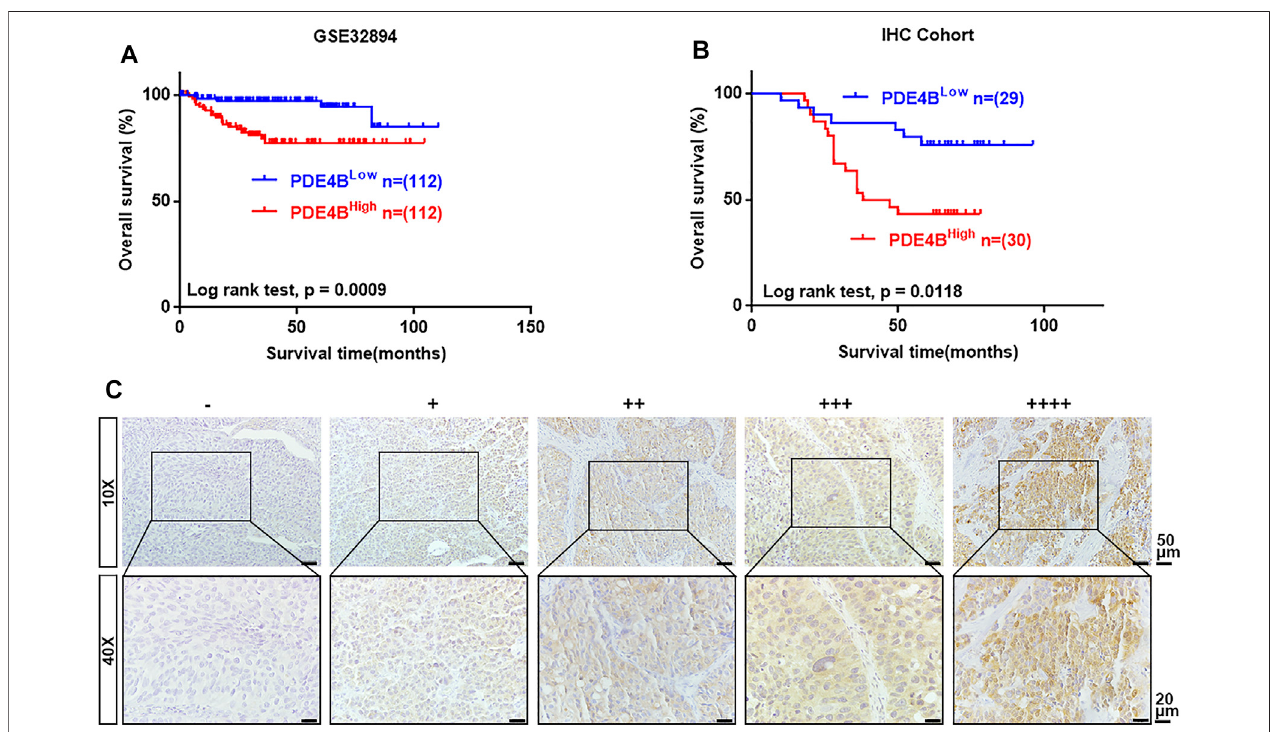
FIGURE3| TheupregulatedlevelofPDE4BcorrelateswithunfavorableprognosisinUBCpatients. (A,B) Kaplan – MeierplotofoverallsurvivalofUBCpatientsfrom GSE32894 (A) and IHC cohort (B) . (C) Representative IHC staining images of different PDE4B staining intensities in UBC tissues. Scale bar, 50 and 20 μ m.